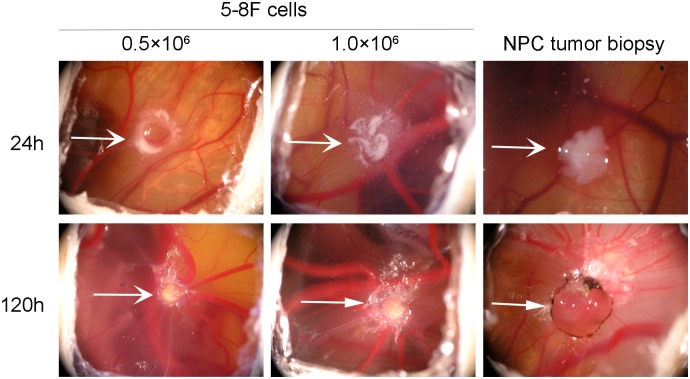
Tumor xenografts in chorioallantoic membranes (CAMs) inoculated with NPC cells or tumor biopsies.CAMs inoculated with 0.5×106 or 1×106 5-8F cells and NPC primary tumors at 24 and 120 h after inoculation. Representative data are shown.